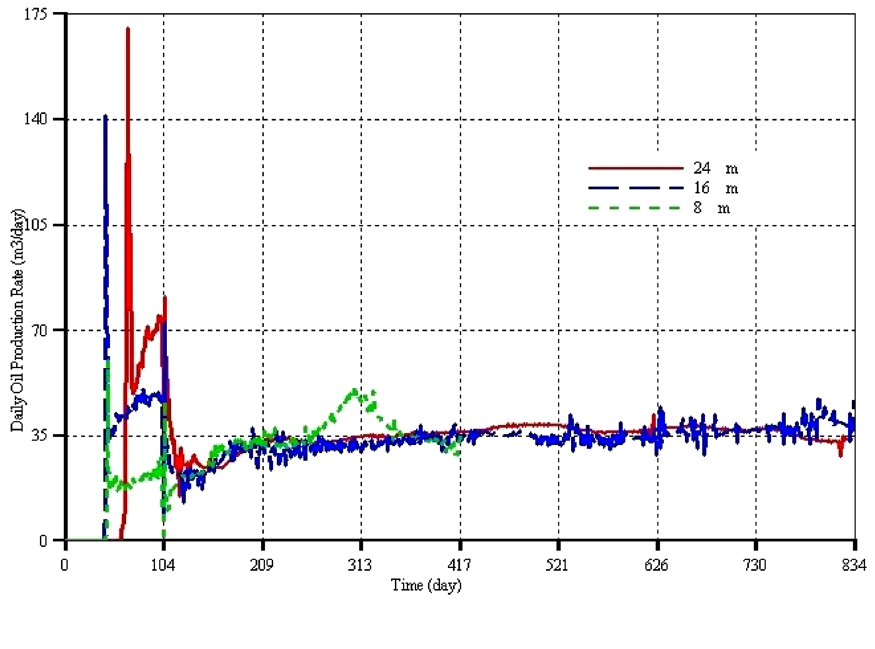
Fig. 3 Cumulative oil produc- tion for the different reservoir thicknesses at constant air injec- tion